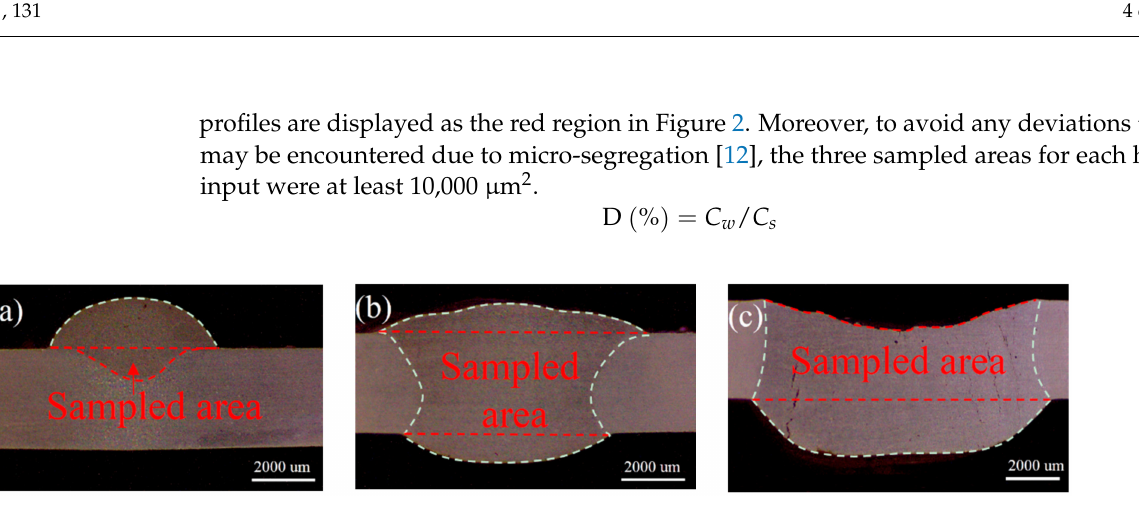
Figure 2. Sampled areas for various weld profiles. Heat input of (a ) 0.12 kJ/mm; ( b ) 0.18 kJ/mm; ( c ) 0.23